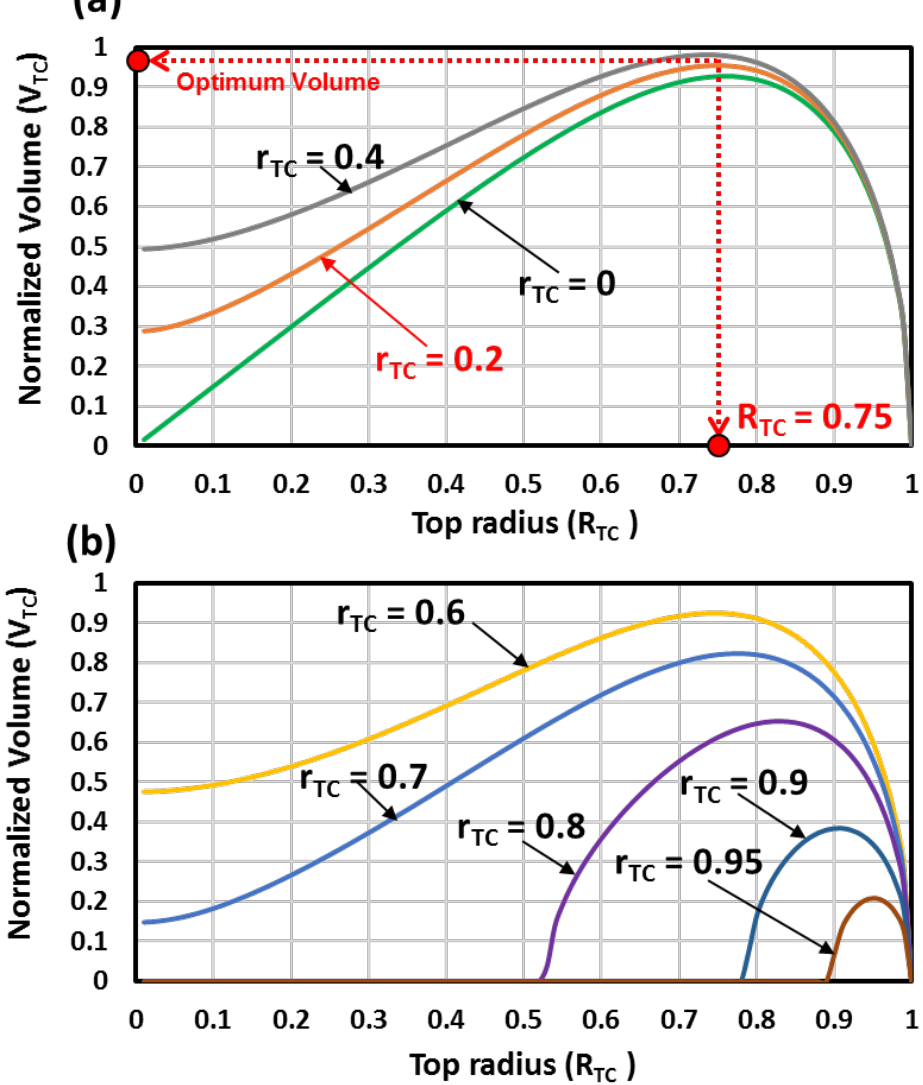
Figure 3. The MH bed volume variations against the top radius and the bottom radius ( a ) for 0 ≤ r TC ≤ 0.4 and ( b ) for 0.6 ≤ r TC ≤ 4.00  r and ( b ) for 95 . 0 6 . 0   TC